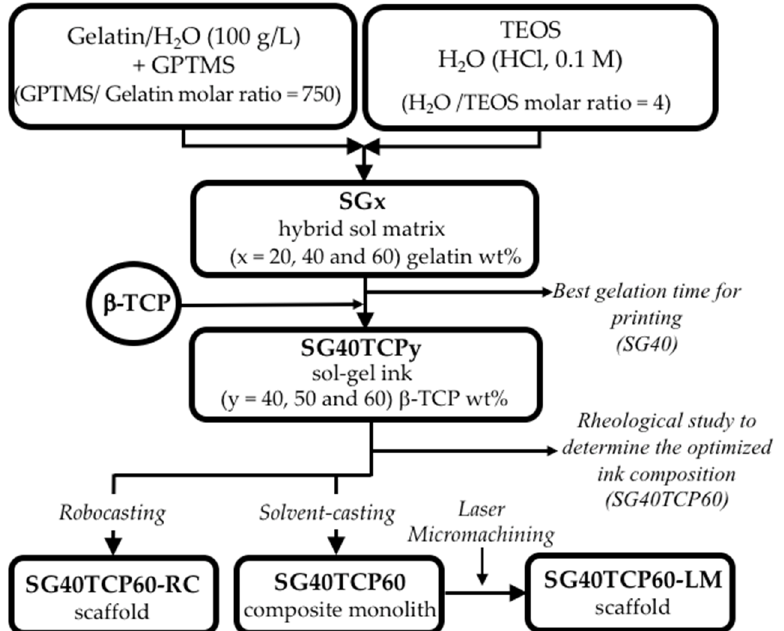
Figure 12. Schematic showing the different processing methods used to prepare SG40TCP60 3D sol-gel-derived scaffolds by robocasting (RC) and laser micromachining (LM). The last-mentioned scaffold was fabricated by laser irradiation of the corresponding monolith composites, which in turn were obtained by solvent casting of SG40TCP60 ink, followed by evaporative drying, (y = 60 wt% represents the β -TCP content for the optimized ink composition according to rheological studies.)